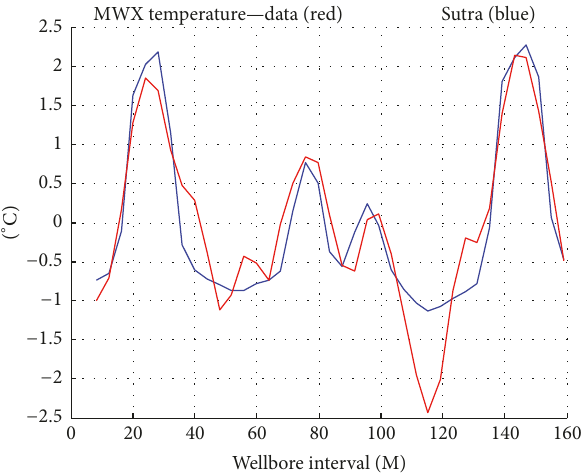
Figure 7: MWX wellbore temperature profile (red) overlying model temperature profile (blue) computed by finite-elements solution of (11)-(12) on global mesh of Figure 1 stochastic poroperm property distribution.